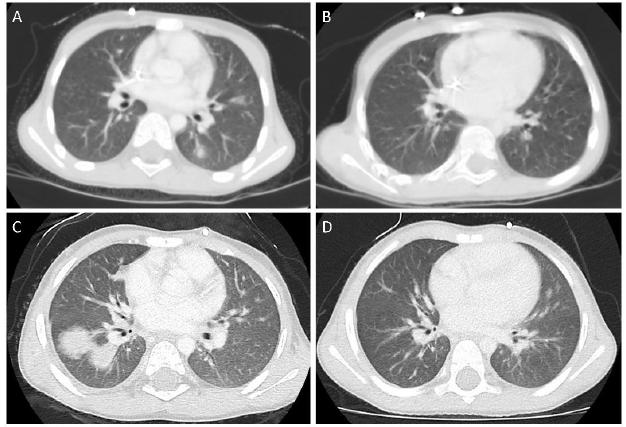
Figure 1. Pulmonary lesion pre- ( A , C ) and post- ( B , D ) antiparasitic treatment in Patient 1 (A,B) and Patient 2 (C,D). A: left lung, inferior lobe, segment 6. C: right lung, inferior lobe, segments 6, 8, 10. Table 1. The clinical, laboratory, radiological, and histopathological characteristics of both patients.